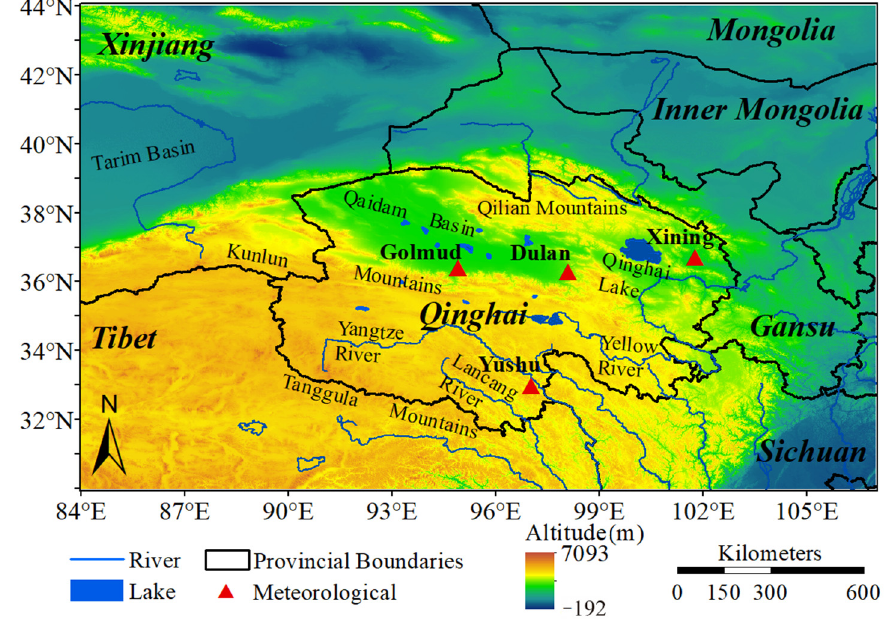
Figure 1. Study area of the northern Qinghai-Tibet Plateau.